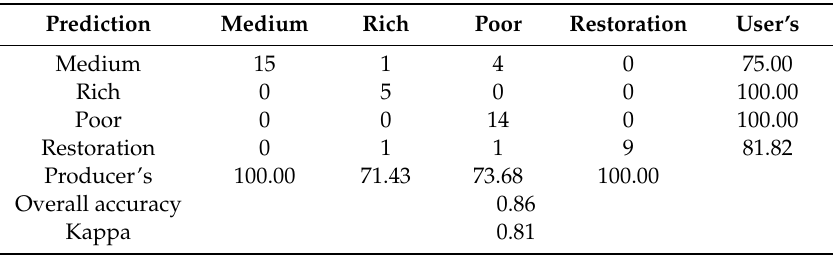
Table A4. Confusion matrix of classification in 2007.